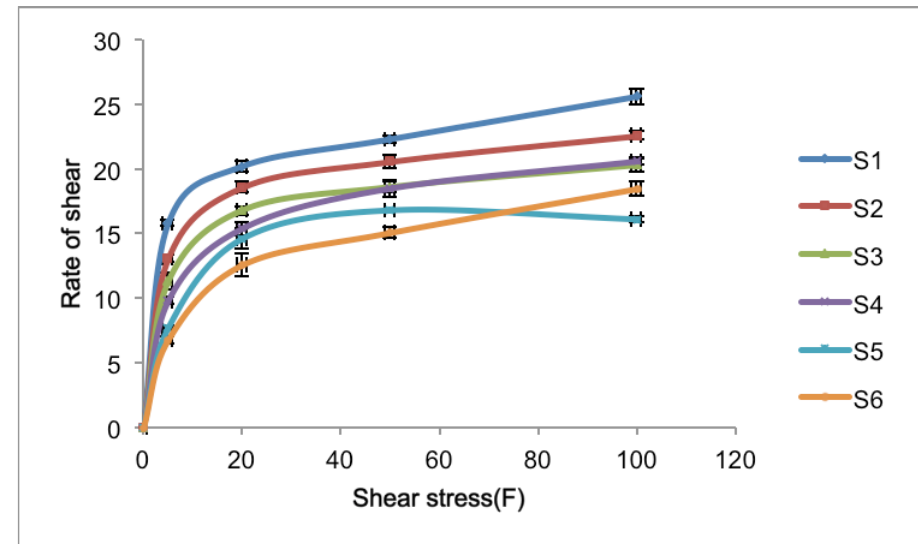
FIGURE 6 - Rheogram of span 60 based organogel.